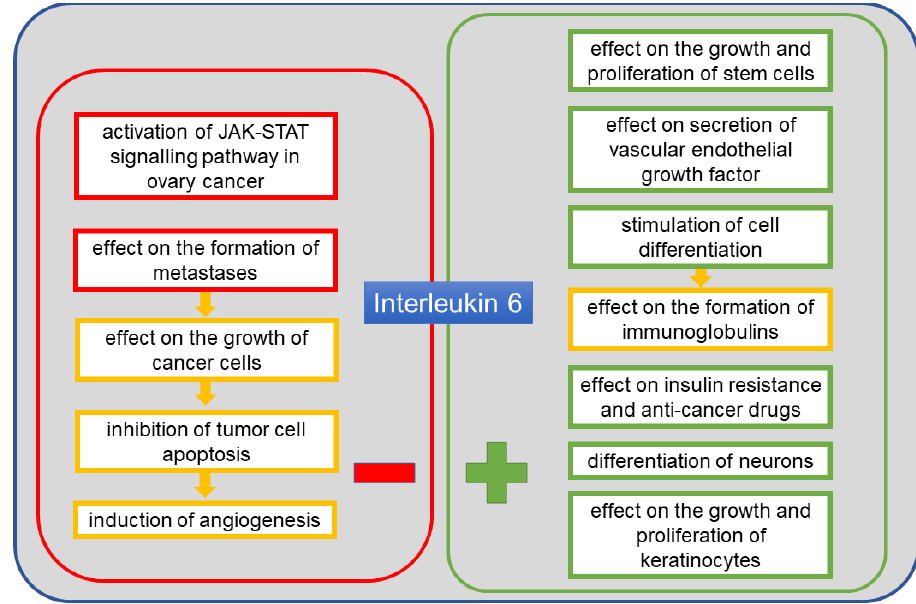
Figure 3. The positive and the negative systemic effects of interleukin 6 (IL-6).